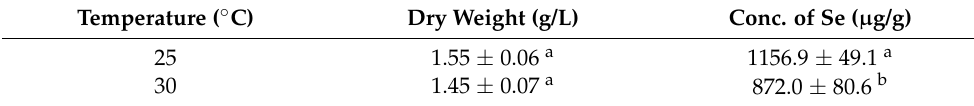
Table 1. A. camphorata mycelial growth at different temperatures in liquid culture.